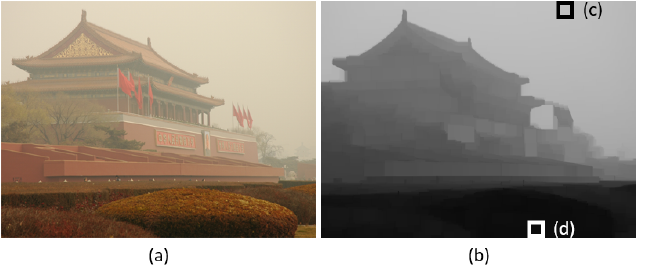
Figure 5. Estimating I s and I 0 : ( a ) input image, ( b ) filtered image using a morphological opening, ( c ) pixels where the intensity is maximum, ( d ) pixels where the intensity is minimum.